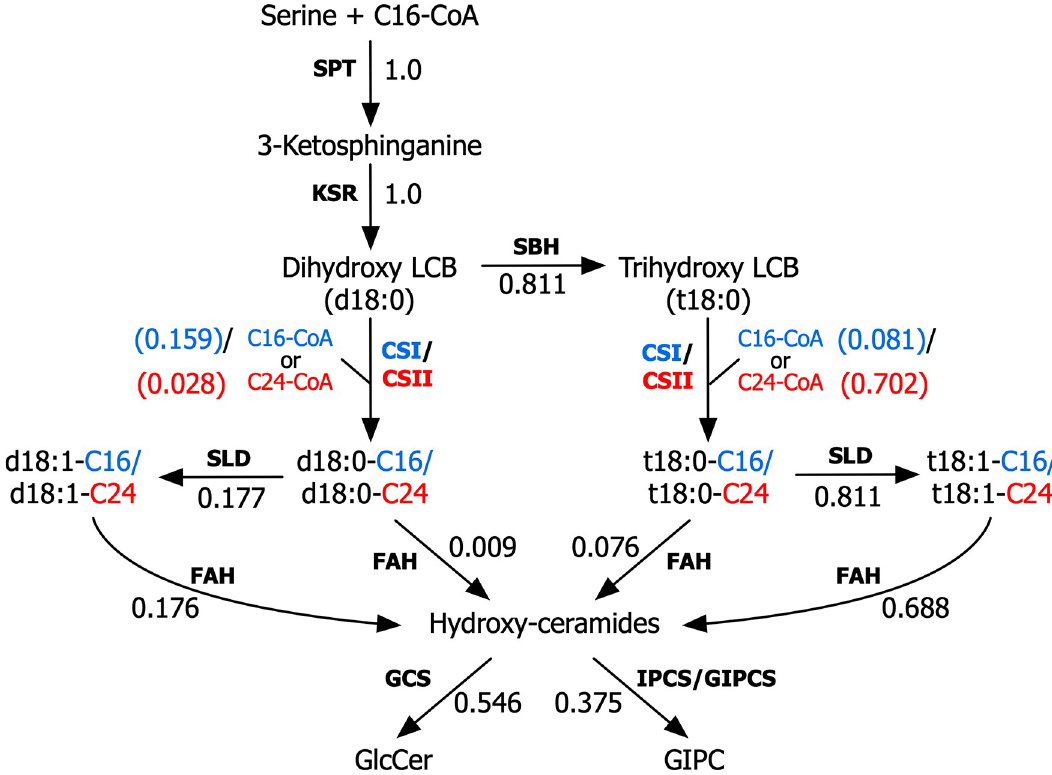
Fig 1. Simplified depiction of the sphingolipid pathway. A metabolic network displaying the main reactions constituting the sphingolipid pathway. Blue flux values correspond to reactions catalyzed by CSI and red flux values correspond to reactions catalyzed by CS II. SPT: serine palmitoyltransferase, KSR: 3-ketosphinganine reductase, SBH: LCB C-4 hydroxylase, CSI: class I ceramide synthase, CSII: class II ceramide synthase, SLD: LCB Δ 8 desaturase, FAH: fatty acid hydroxylase, GCS: glucosylceramide synthase, GlcCer: glucosylceramide, GIPCS: glycosyl inositolphosphoceramide synthase, LCB: long chain base. C16 and C24 are fatty acids of length 16 and 24 carbons, respectively.